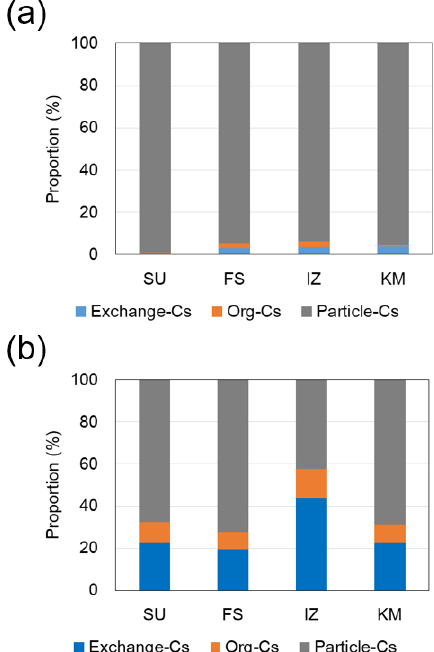
Figure 5. Proportion of exchangeable, organic and particle bound fractions of 137 Cs in soil of 0–2cm depth (a) and bottom sediment by an Ekman–Berge sampler (b)